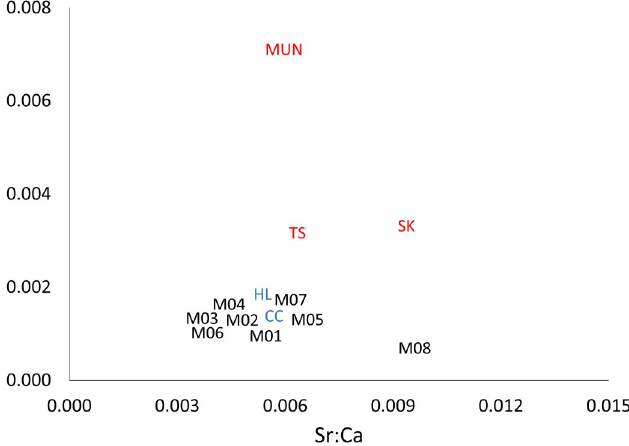
Fig 6. Ba/Ca ratios versus Sr/Ca ratios in the Mekong mainstream and tributaries. Labels at each point refer to the sampling sites in Fig 1 and Table 1. Black letters correspond to sites on the Mekong mainstream, red letters to sites on tributaries, and blue letters to sites on